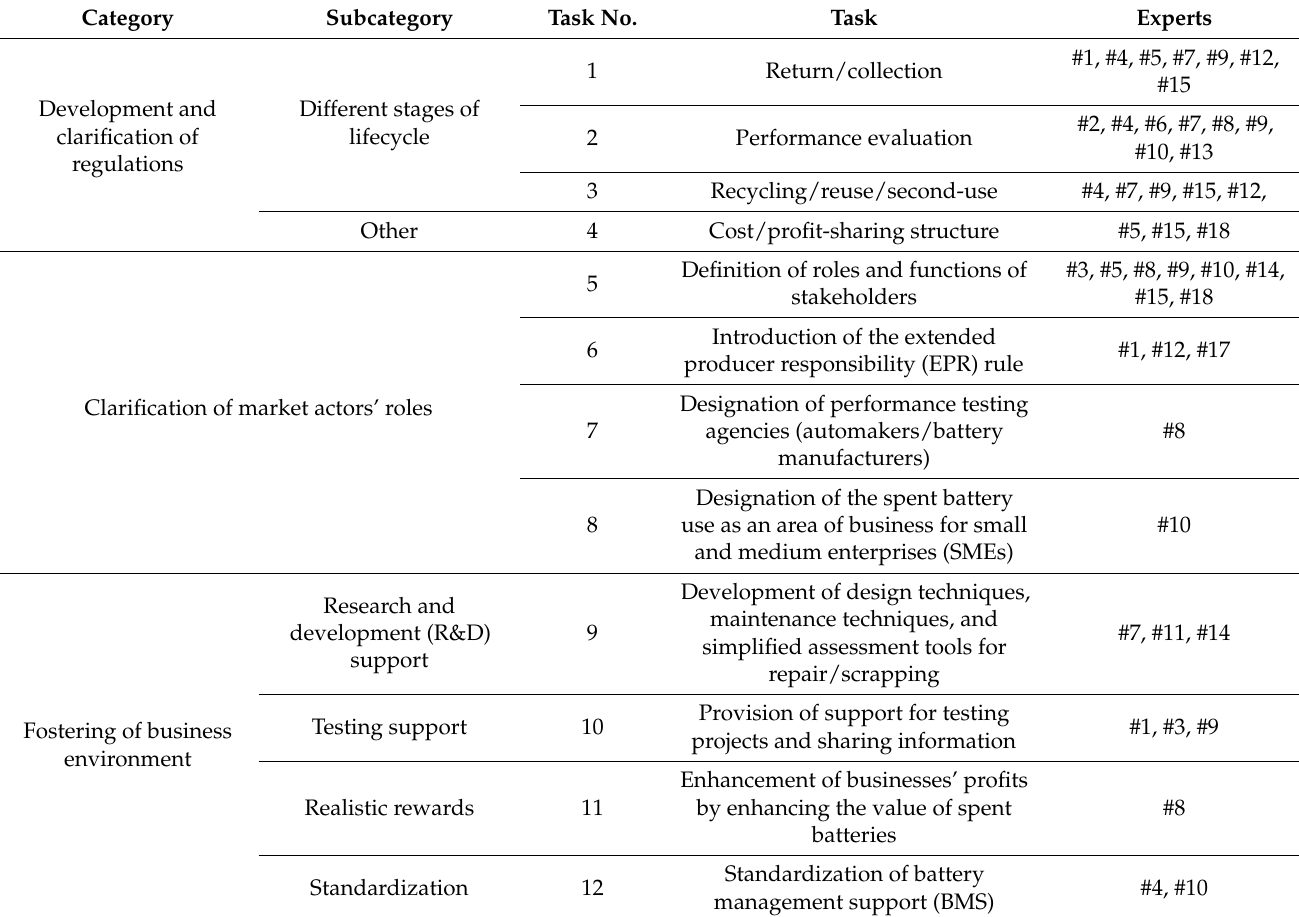
Table 3. Top-priority policy